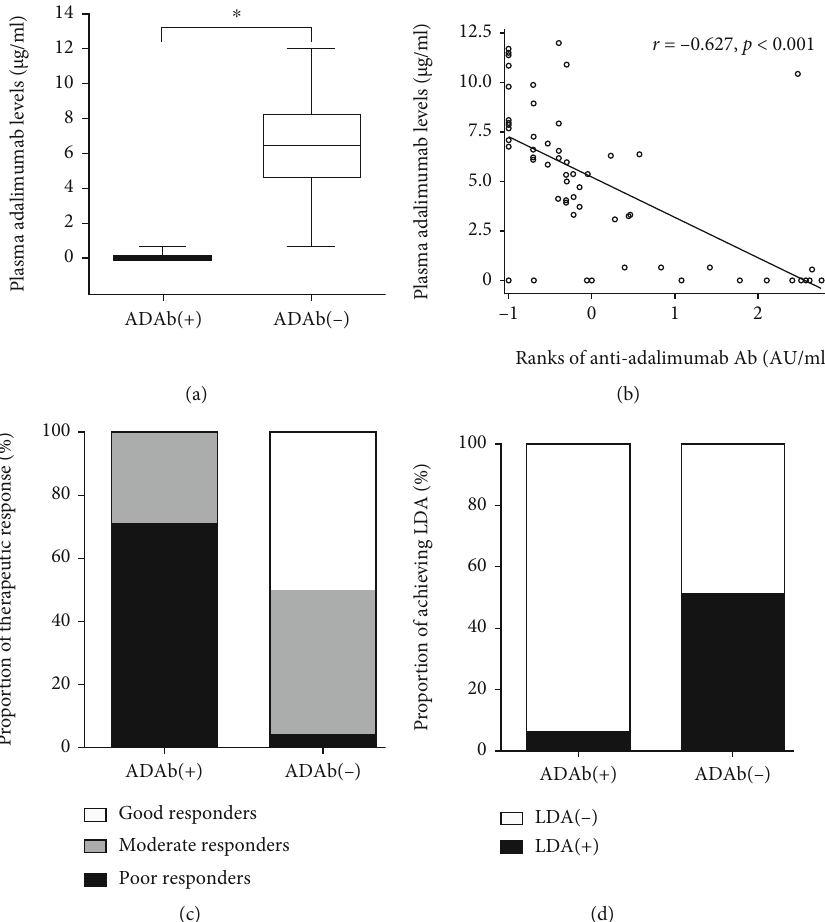
Figure 2: Comparison of plasma drug levels between RA patients with positive ADAb [ADAb(+)] and negative ADAb [ADAB( − )] assessed at week 24 of adalimumab therapy (a). The correlation between plasma ADAb titer and drug levels (b). The proportion of EULAR therapeutic response (c) and the proportion of achieving low disease activity (d) at week 24 in RA patients with ADAb(+) and ADAb( − ). The ranks of the anti-adalimumab Ab value were presented as the log transformation. RA: rheumatoid arthritis; EULAR: European League Against Rheumatism. Good EULAR responders are de fi ned as patients who have a decrease in DAS28 from baseline ð Δ DAS28 Þ > 1 : 2 and a DAS 28 ≦ 3 : 2 ; moderate responders have either Δ DAS28 > 1 : 2 and a DAS28 > 3 : 2 or Δ DAS28 of 0.6-1.2 and a DAS28 ≦ 5 : 1 ; poor responders are those who have either Δ DAS28 < 0 : 6 or a DAS28 > 5 : 1 . Low disease activity was de fi ned as DAS28 ≦ 3 : 2 . The data were presented as boxplot diagrams, with the box encompassing the 25 th percentile (lower bar) to the 75 th percentile (upper bar). The horizontal line within the box indicates the median value and the horizontal lines above and below the box represent the maximum and minimum values, respectively, for each group. ∗ p < 0 : 001 , ADAb(+) versus ADAb( − )